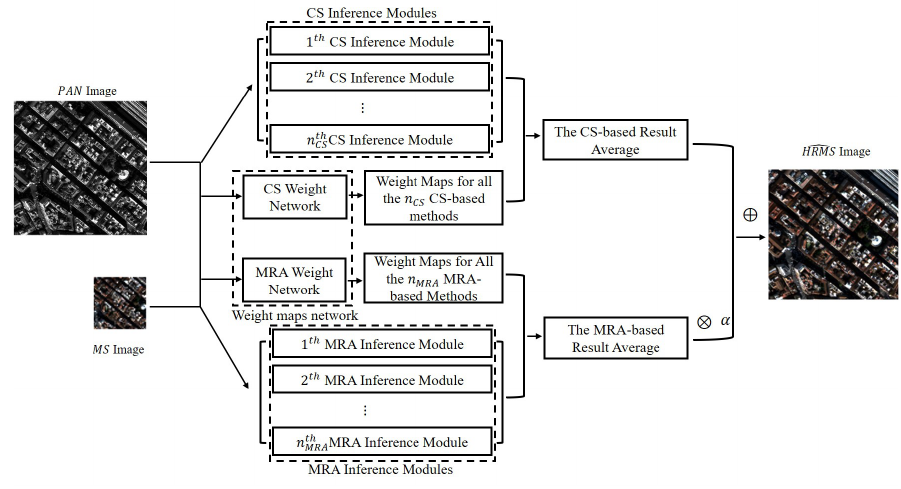
Figure 3. Blockdiagram of the proposed PWNet for pansharpening. The proposed method can be divided into three independent part, i.e., the weight maps network, the CS inference modules and the MRA inference modules. The weight maps network takes the reduced MS and PAN image as inputs, and outputs weight maps for each of the CS-based and MRA-based methods. At the same time, the CS inference modules and the MRA inference modules generate HRMS images according to specific pansharpening methods. Finally, the estimated HRMS image is obtained by averaging all HRMS images estimated by the selected CS-based and MRA-based methods with the weight maps generated by the weight maps network.